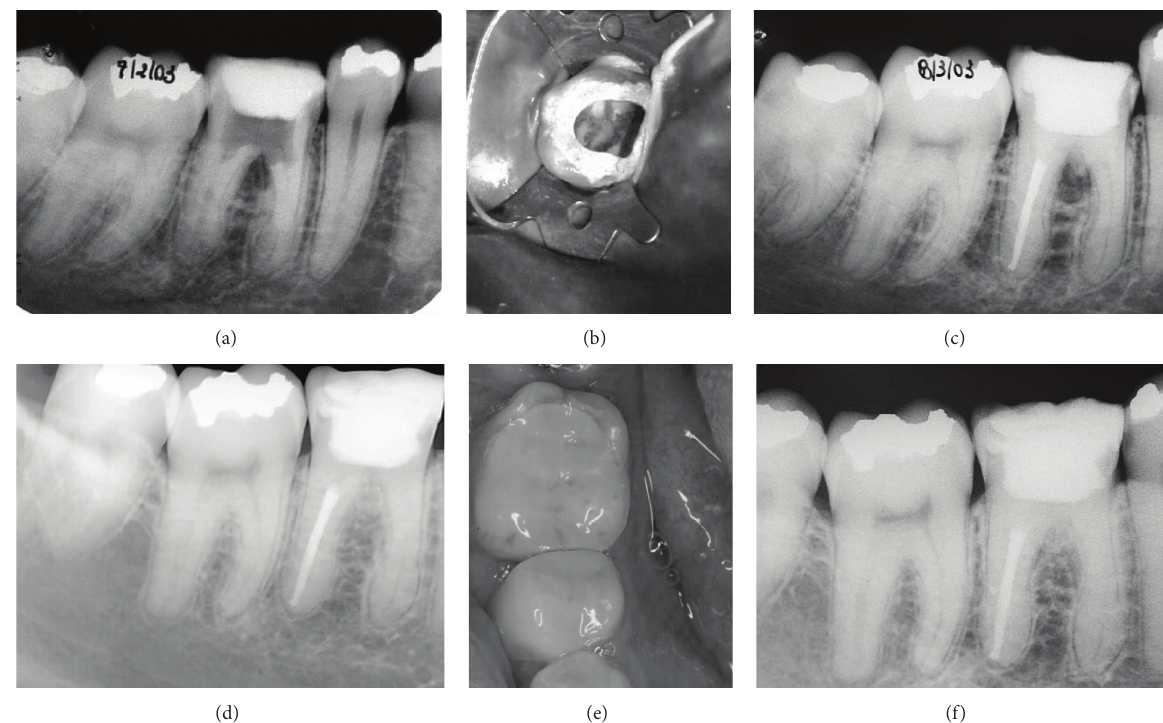
Figure 2: (a) Radiographic evaluation after perforation treatment. (b) Clinical aspect after the cavity filling. (c) Radiograph control 6 months later, 4 years later (d). (e) Clinical view after the tooth restoration and radiograph control 9 years later